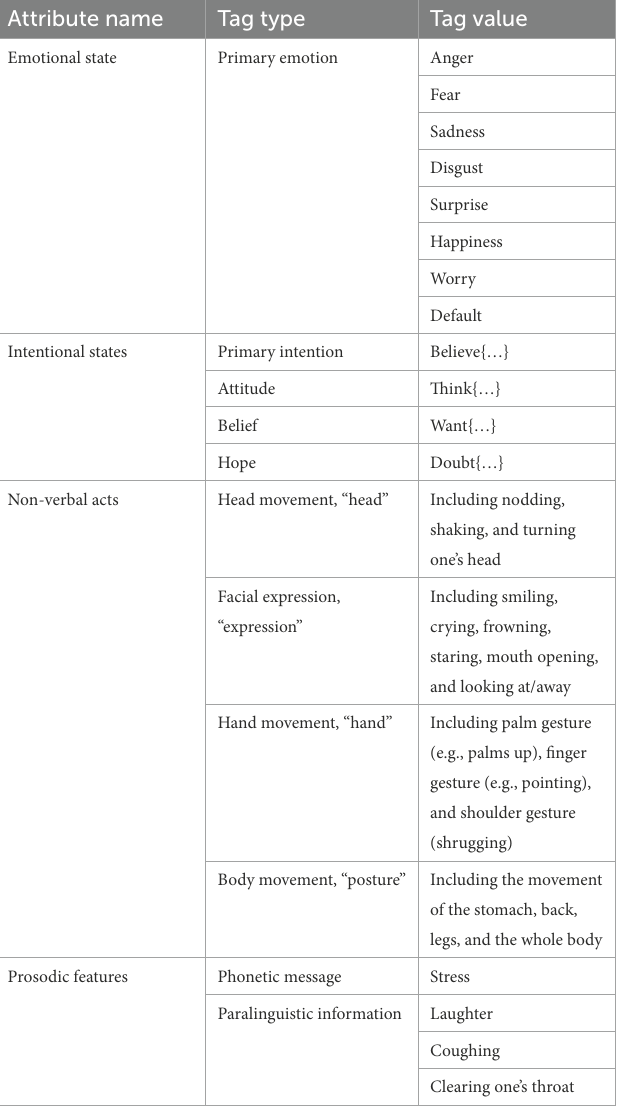
TABLE 3 The labeling method of four properties. Attribute name Tag